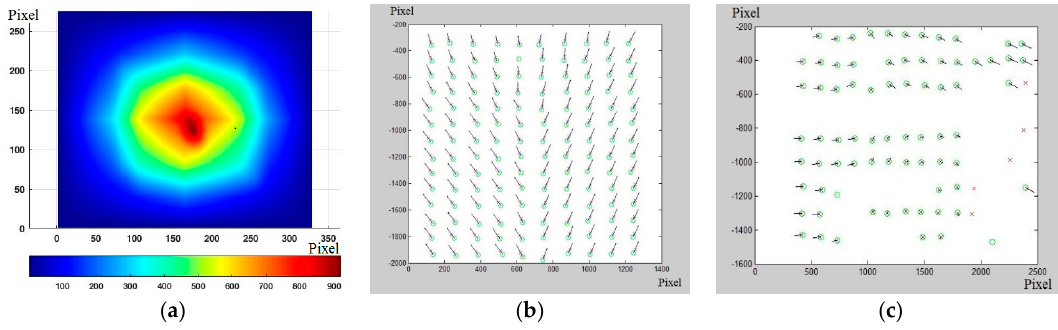
Figure 5. ( a ) Map of local cross correlation, from which the displacement vector is extracted. ( b , c ) Example of displacement applied vectors obtained by means of the method used.